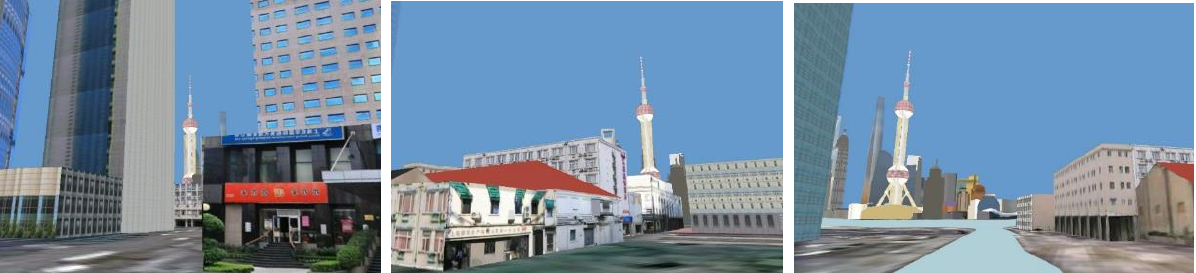
Fig.7 visibility of the landmark from the west of Xinjian Road